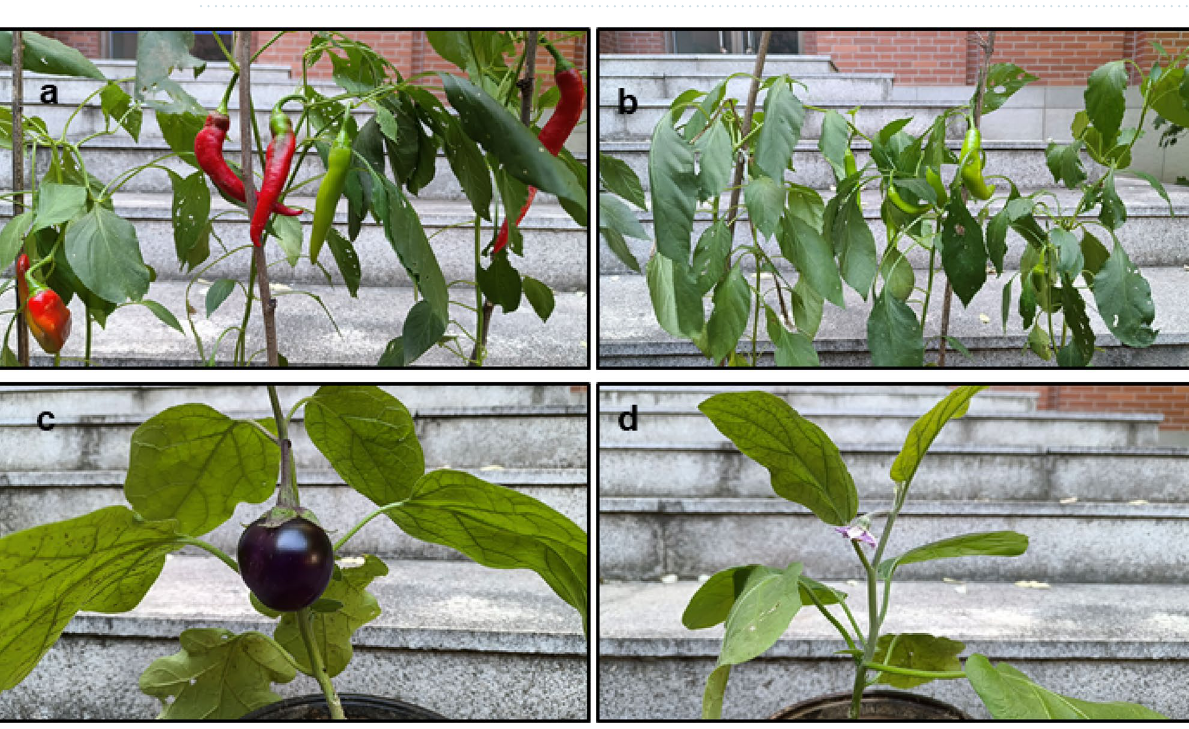
Figure 8. Analysis of plant growth characterized by the flowering and fruiting process at the end of the 3 months. ( a ) Chili grown in soil with effluent, and its control without effluent ( b ); ( c ) brinjal grown in soil with effluent and its corresponding control grown without effluent ( d